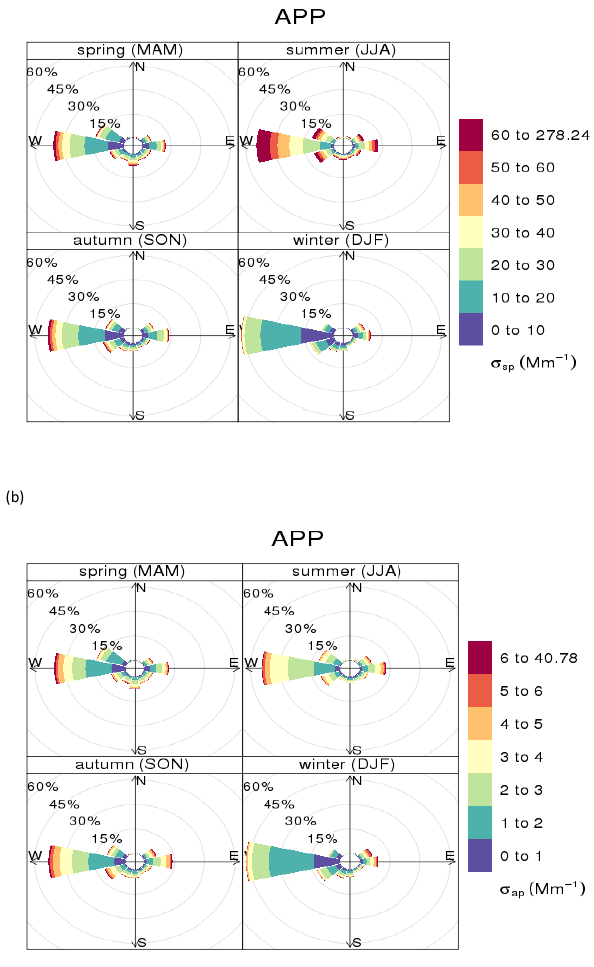
Figure 5. Pollution rose diagrams of PM 1 σ sp and σ ap for individual seasons at APP over the 2010–2013 period. The percentages at a given radius represent the percentage of hourly profiles for a given wind